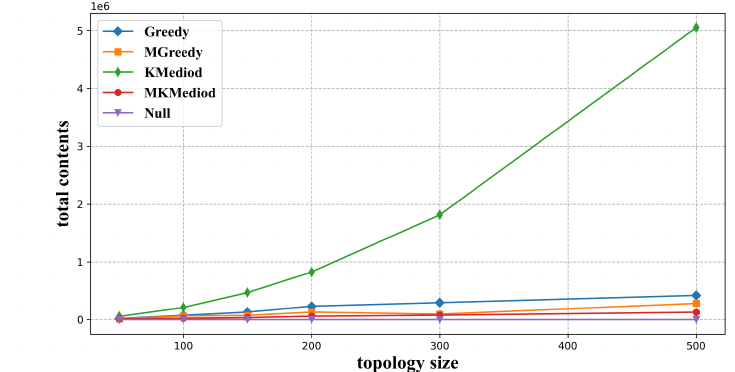
Figure 7. Total storage load of each algorithm with different network